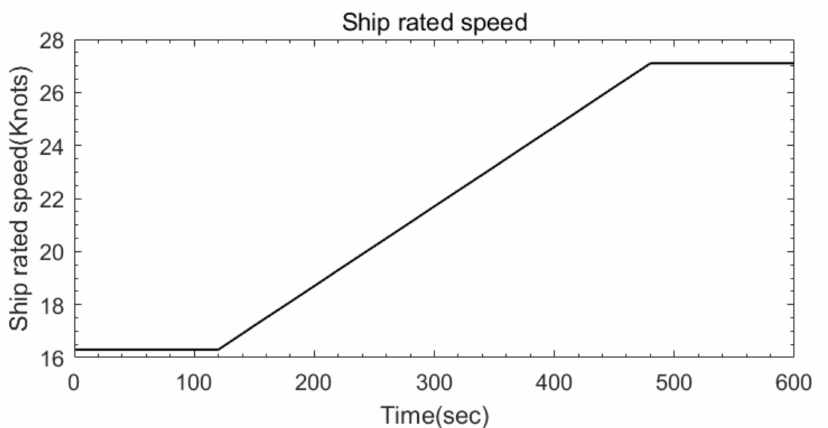
Figure 8. Changing curve of ship speed V .